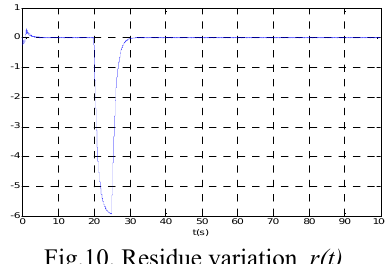
Fig.8. Frequency evolution F(t)